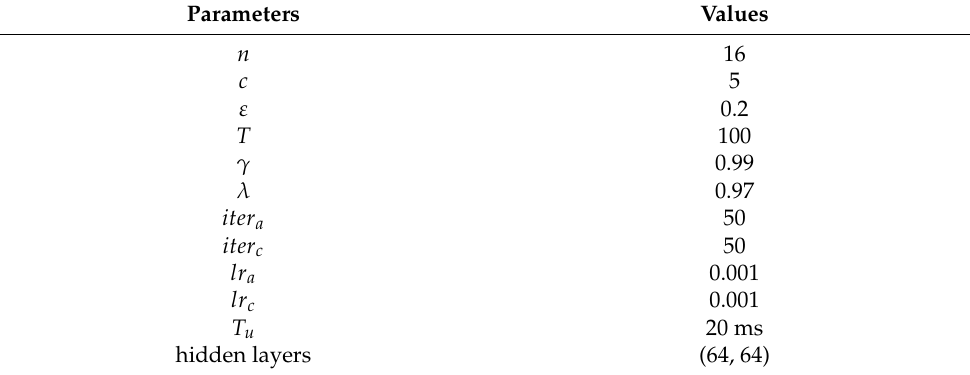
Table 1. Simulation